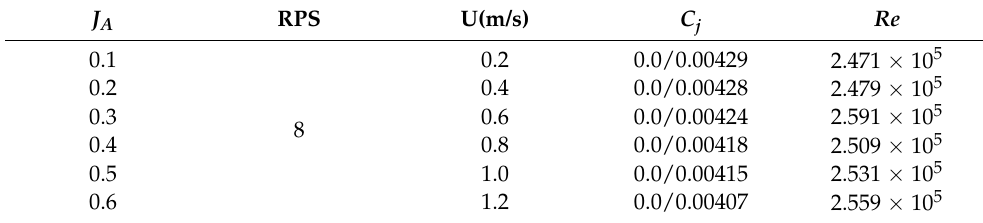
Table 2. Experimental